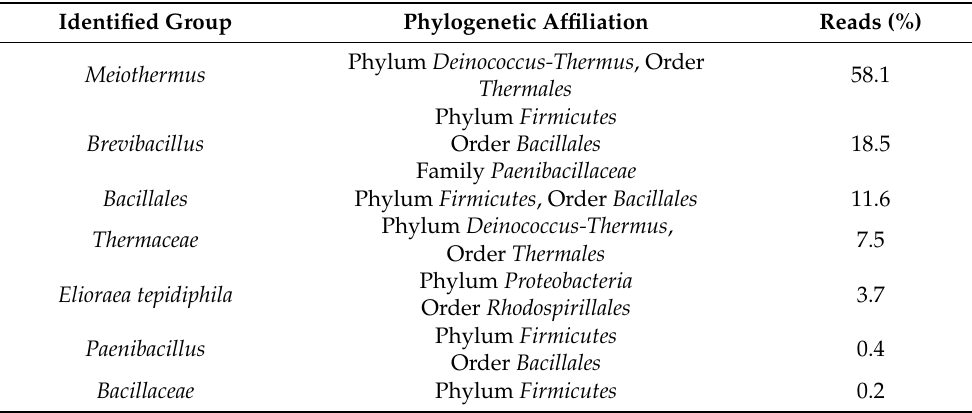
Figure 1. Bacterial orders represented (%) in: ( A ), MKC-C; ( B ), MKC-P. Table 2. Taxonomic groups identified in